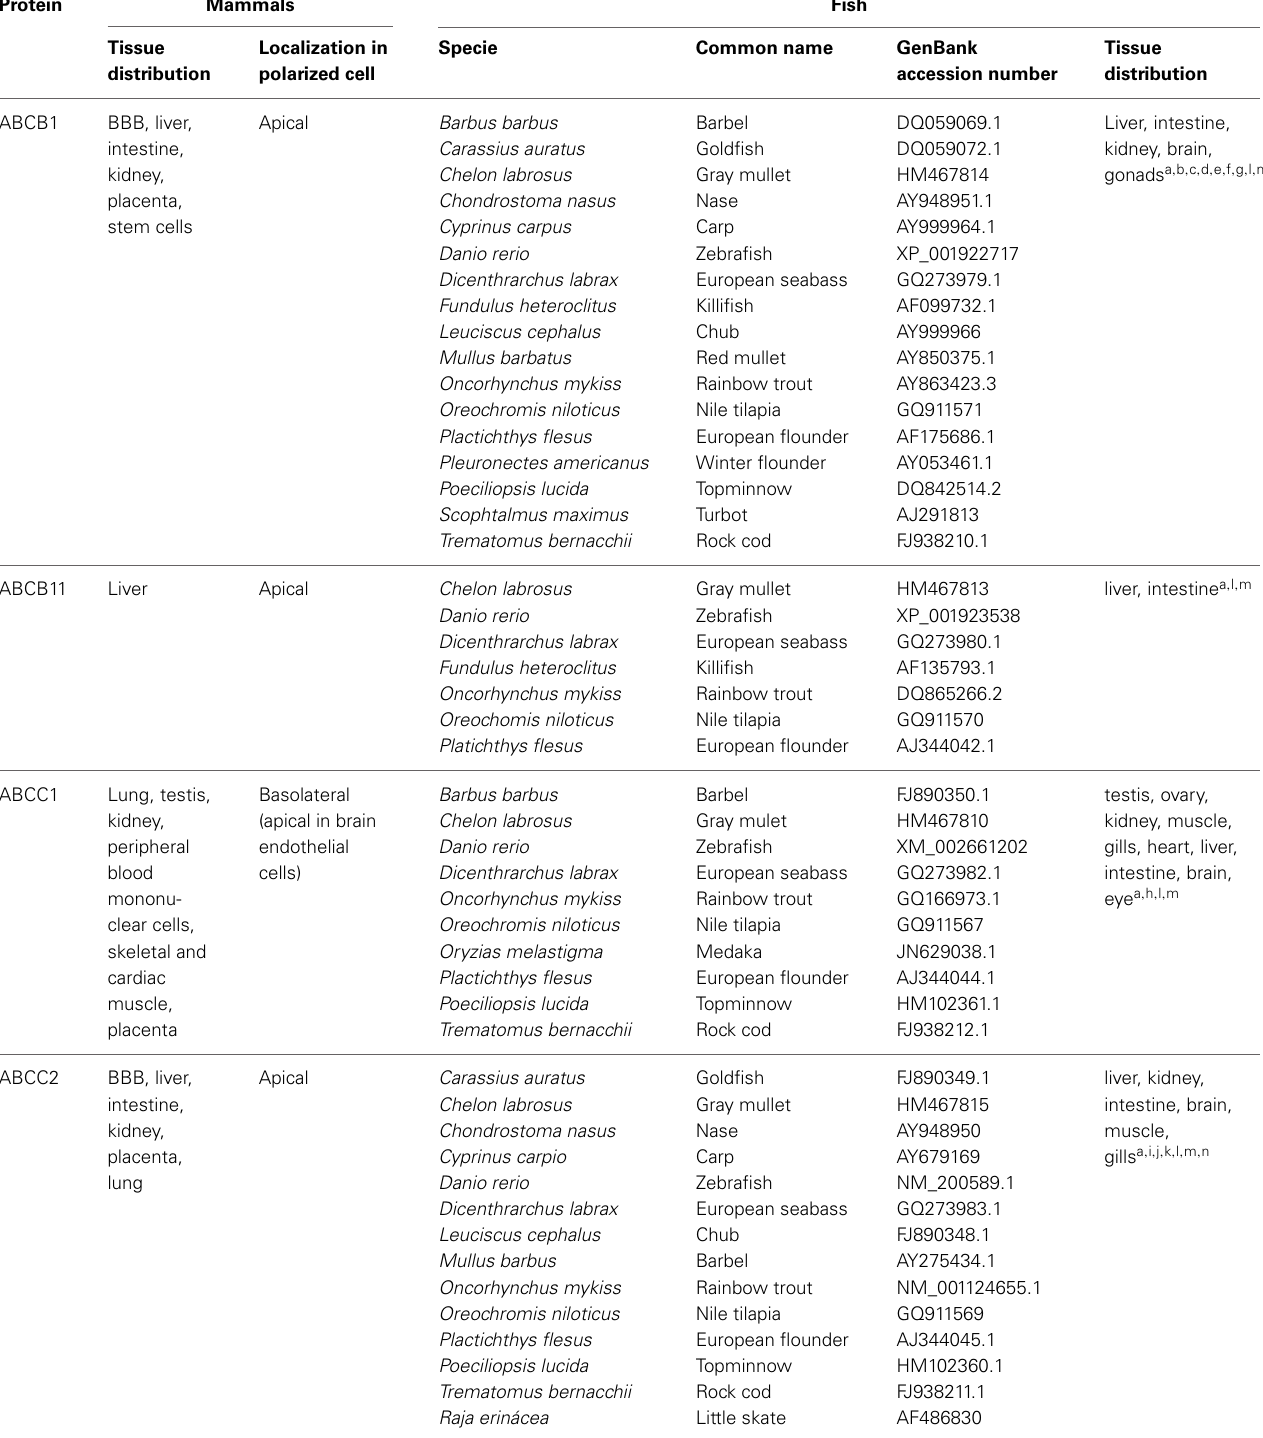
Table 2 | ABC transporters involved the efflux of toxic compounds, fish species where they were identified and tissue distribution pattern in mammals and